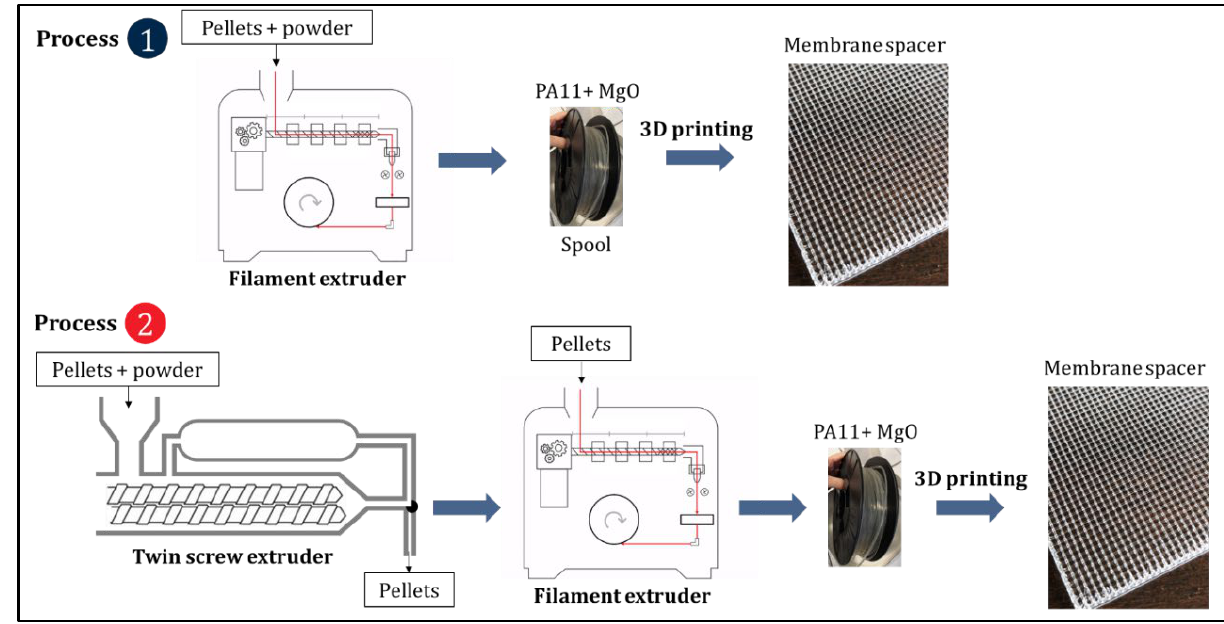
Figure 25. Processes used for the fabrication of tailored made and tunable membrane spacer.